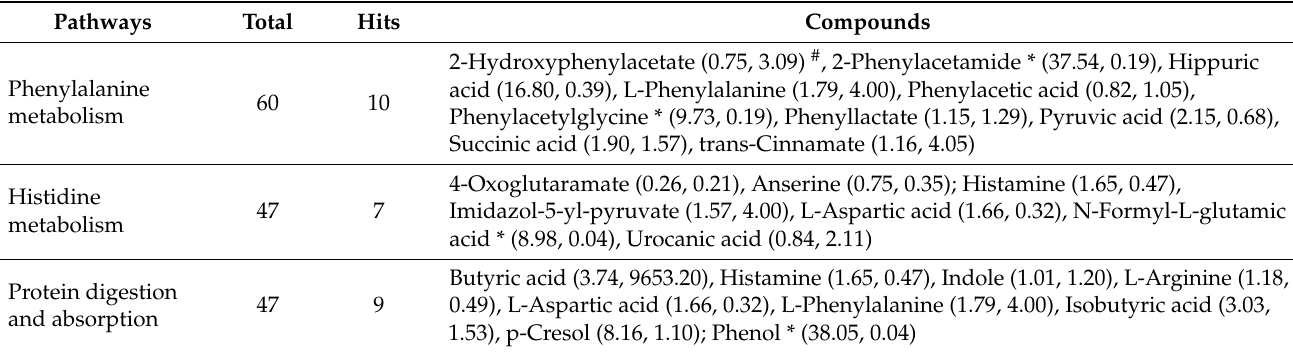
Table 2. The common metabolic pathways between the TB and TB + AB groups as well as the TB + AB and TB + FMT groups.